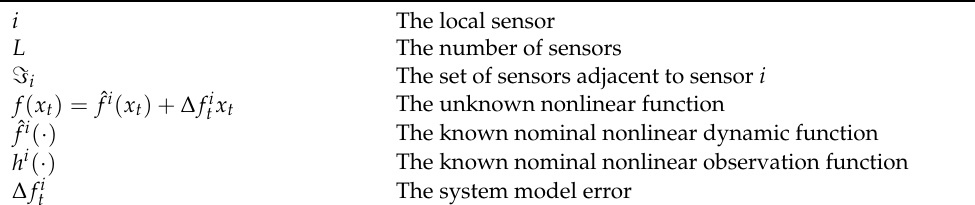
Table 1. The symbolic nomenclature of Formula